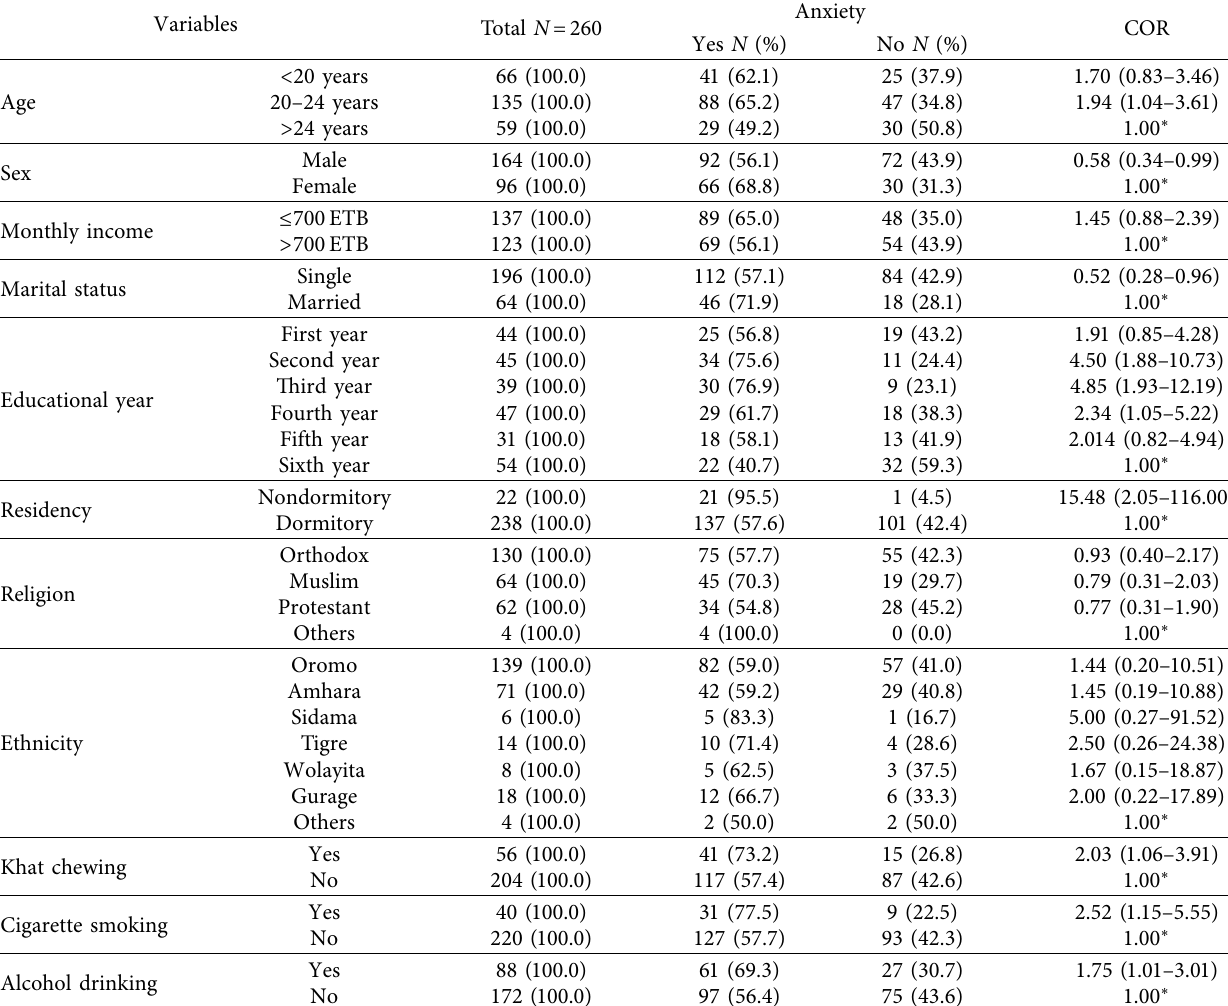
Table 6: Bivariate logistic regression of factors associated with anxiety, N � 260, AU, January 2019.